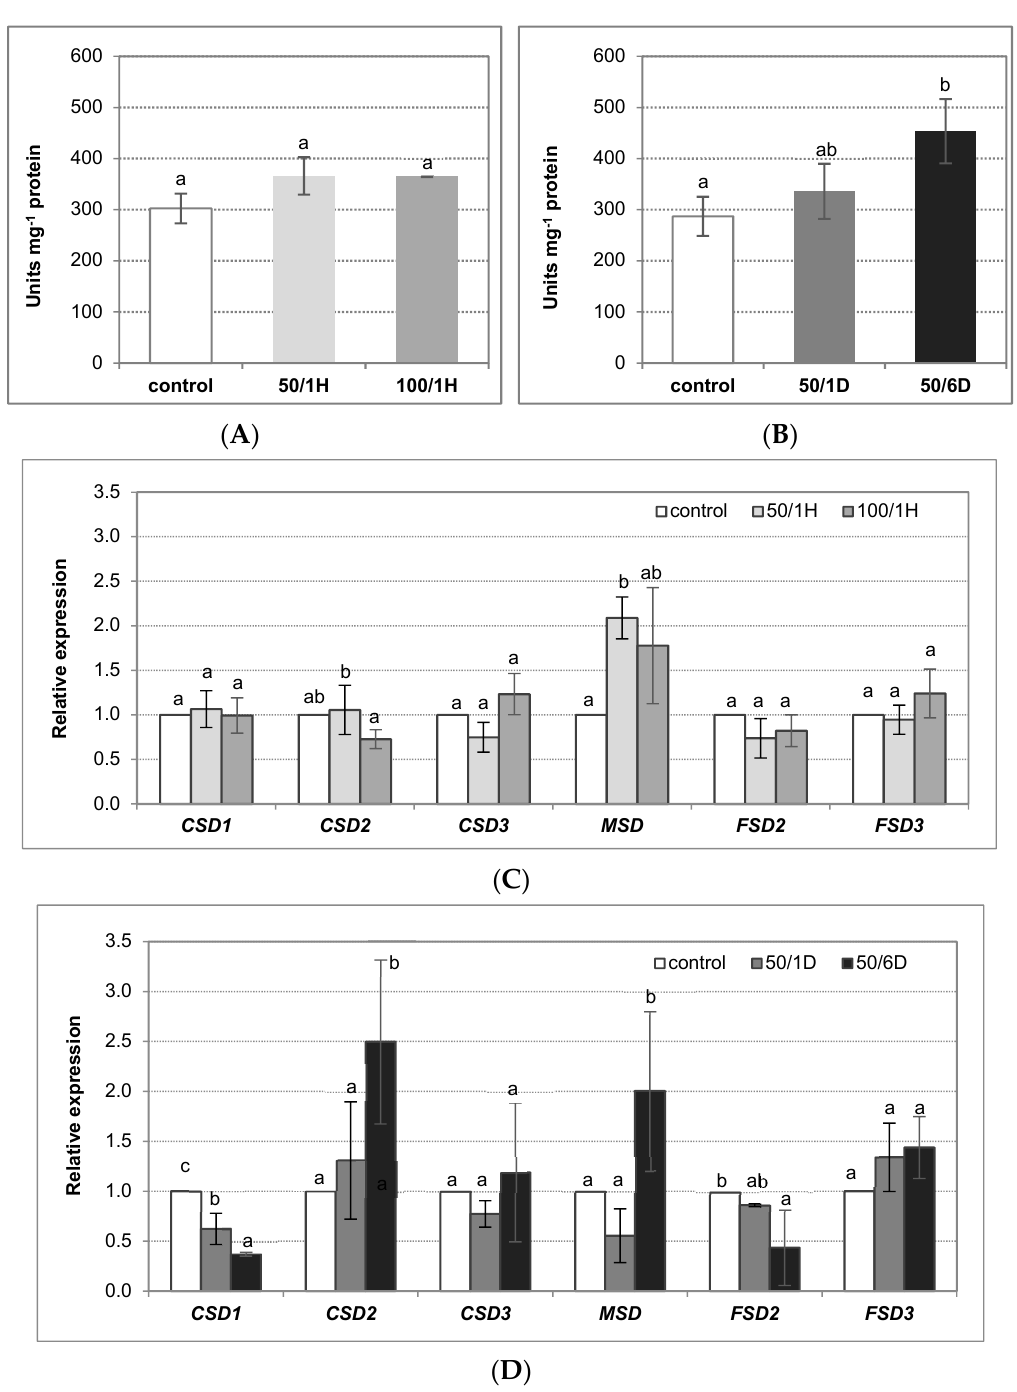
Figure 4. Superoxide dismutase activity ( A , B ) and relative expression of SOD encoding genes ( C , D ) in the tissues of cucumber roots exposed to salinity. The cucumber seedlings were treated with: ( A , C ) 50 mM or 100 mM NaCl for 1 h (50/1H and 100/1H, respectively); ( B , D ) 50 mM NaCl for 1 or 6 days (50/1D and 50/6D, respectively). ( A , B ) SOD activity was determined in the roots, as described in Materials and Methods. The presented results are the means ± SD of three independent experi- ments, each run in triplicate, and are expressed as units g − 1 FW. ( C , D ) The total RNA was isolated from the cucumber roots, and real-time PCR analysis was performed, with CsCACS as a reference gene, as described in Materials and Methods. The results are shown as the means ± SD of three replications. Different letters show different homogeneous groups of means calculated by Duncan’s multiple range test (significant at p < 0.05).